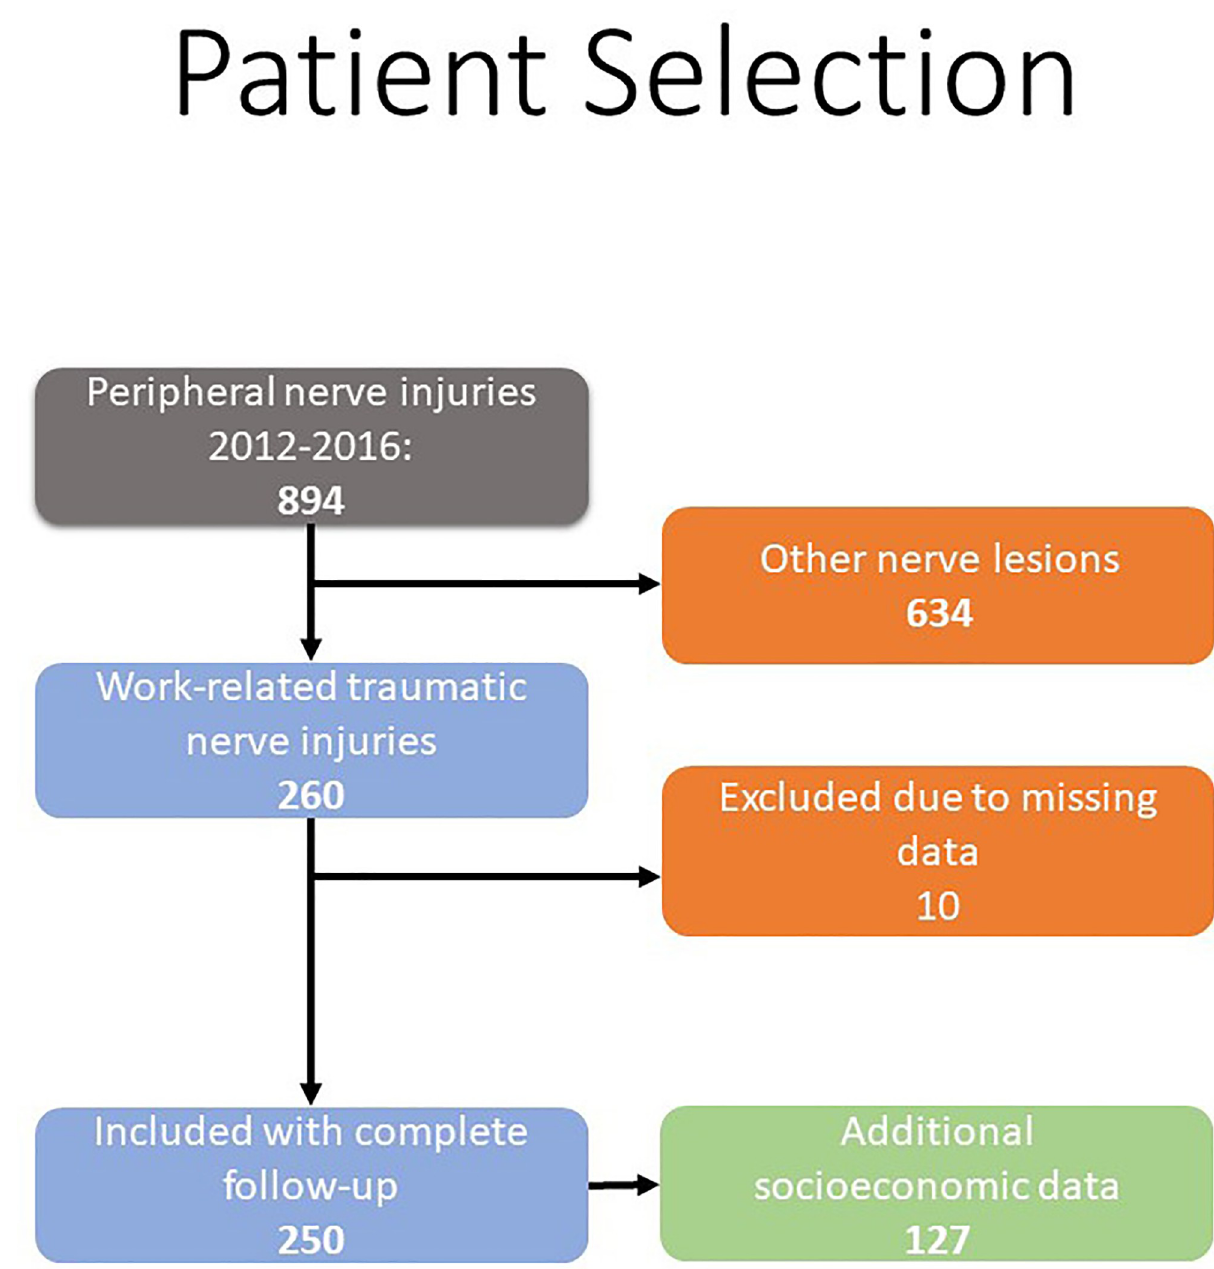
Fig 1. Flow-chart of patient selection: Selection and analysis of patients for this study.